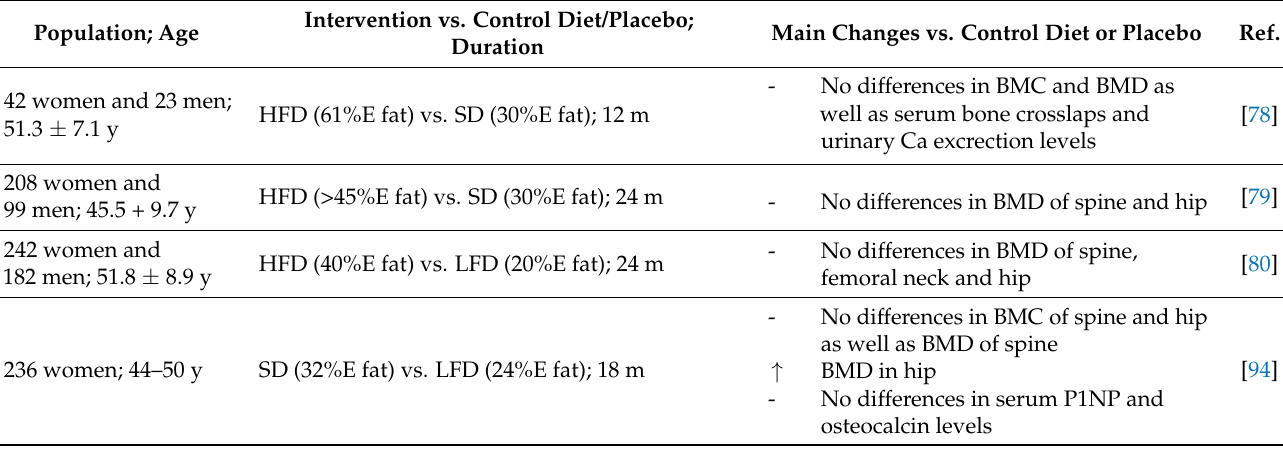
Table 2. Studies in humans investigating the role of fat intake on bone